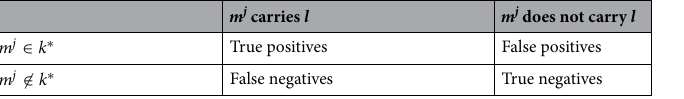
Table 5. Contingency table for subcluster–label association. m j ∈ k ∗ is to be read as the measurement m j is belongs to k ∗